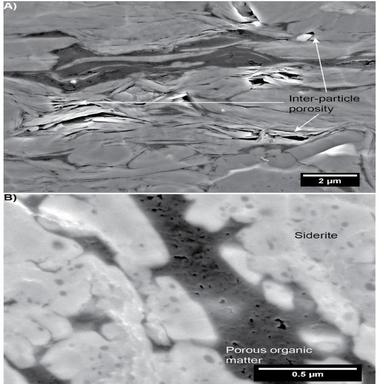
SEM images of BIB polished surface of Marcellus Shale. A) Image illustrating micron-sized inter-particle porosity with elongated to equant shape and also porosity in the organic matter (dark in the image). B) Organic hosted porosity of mainly equant shape and mostly uniform size of 50–100 nm.